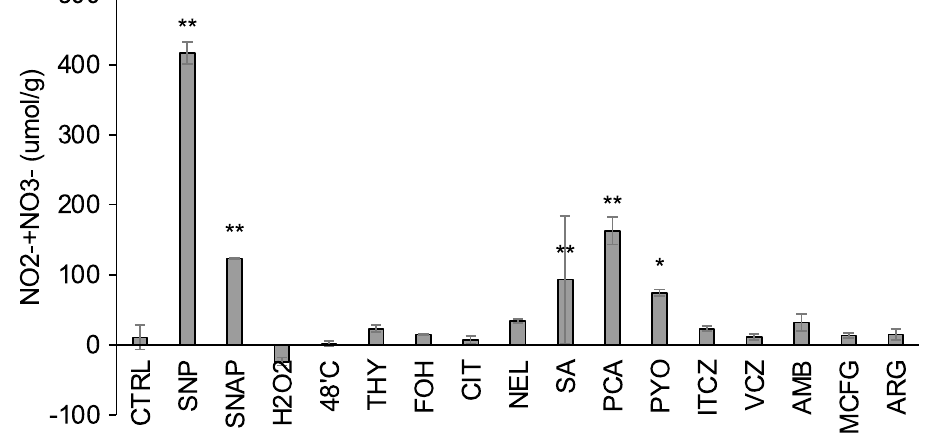
Figure 5. Measurement of the intracellular NO level using the Griess method. Aspergillus fumigatus was grown in GMM(Pro) and treated with the shown stressors. Each extract was obtained as described for the quantification of DCFH- or DAF-FM-related fluorescence. An aliquot was used for protein quantification, and proteins were removed in the rest of cell extracts. To determine the NO level of the sample, absorbance at 540 nm was quantified using an NO 2 /NO 3 Assay Kit-C II (Colorimetric). The signal intensity was calculated in accordance with the instructions. For the L-arginine supplementation, grown cells were treated with 10 mM L-arginine. The data were obtained from three biological replicates, and the error bar represents the standard deviation. Significant differences between samples were examined using Dunnett’s tests and are indicated as * p < 0.05; ** p <